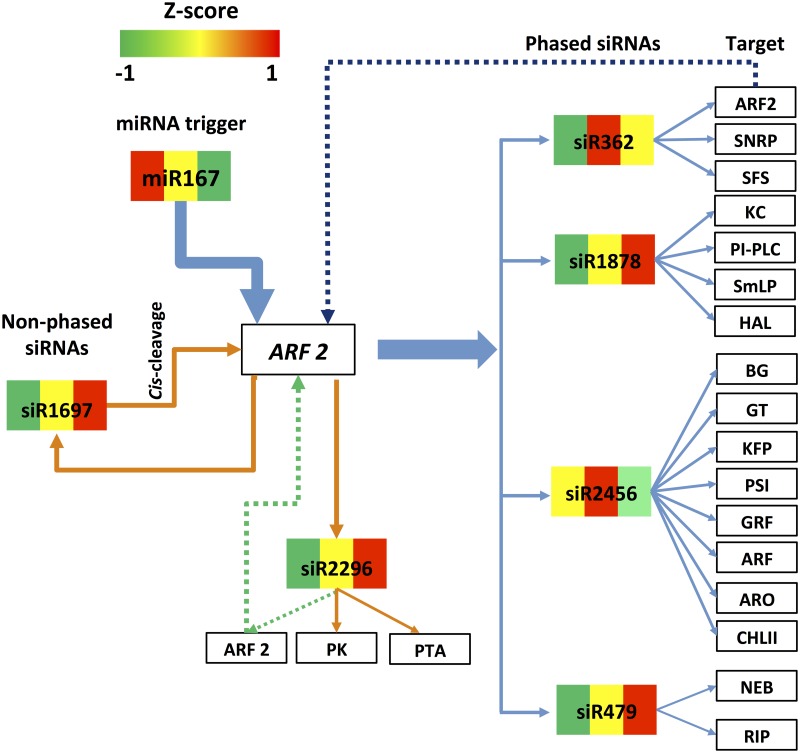
miR167-directed pha-siRNA regulatory pathway.The miR167 directed pha-siRNA regulatory pathway is shown as indicated. The blue arrows and lines show the regulatory pathway of pha-siRNA s produced from ARF2, while the dark orange arrows and lines show the regulatory pathway of cis-cleavage by nonpha-siRNA, siR1697. The broken green and dark blue arrows show two potential auto-regulated pathway of Auxin by phased and non-phased siRNAs. The colors in the boxes from left to right represent the Z-score of expression values of sRNAs in the leaf, flower and boll, respectively. ARF (2): Auxin response factor (2); SNRP: small nucleolar RNA-associated protein; SFS: Splicing factor subunit; KC: kafirin cluster; PI-PLC: PI-PLC X domain-containing protein; SmLP: snRNA-associated Sm-like protein; HAL: PAP-specific phosphatase HAL2-like family protein; BG: Beta-galactosidase; GT: Glycosyltransferase; KFP: Kinase family protein; PSI: Photosystem I chain III family protein; GRF: GRF1-INTERACTING FACTOR 2 family protein; ARO: ARO1-like protein; CHLII: hlorophyll A/B binding protein; NEB: Neurobeachin; RIP: 60S ribosomal protein L5.